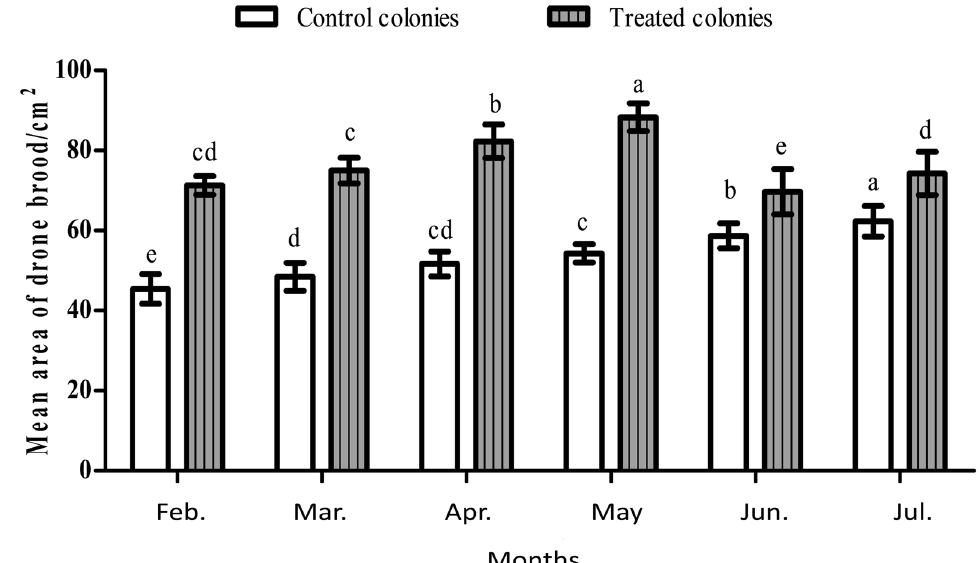
Fig. 2 The average ( SE) area of sealed drone’s brood/cm 2 in control and treated colonies ±